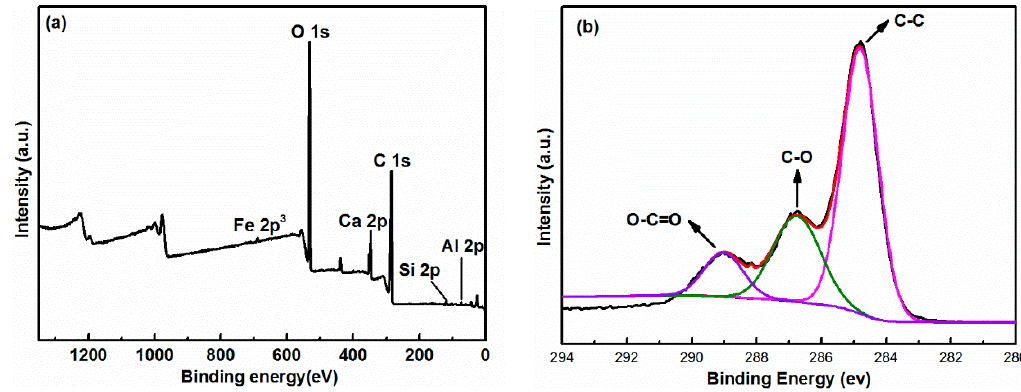
Figure 9. ( a ) X-ray photoelectron spectroscopy (XPS) survey spectra, and ( b ) deconvoluted C1s spectra of CGPC.